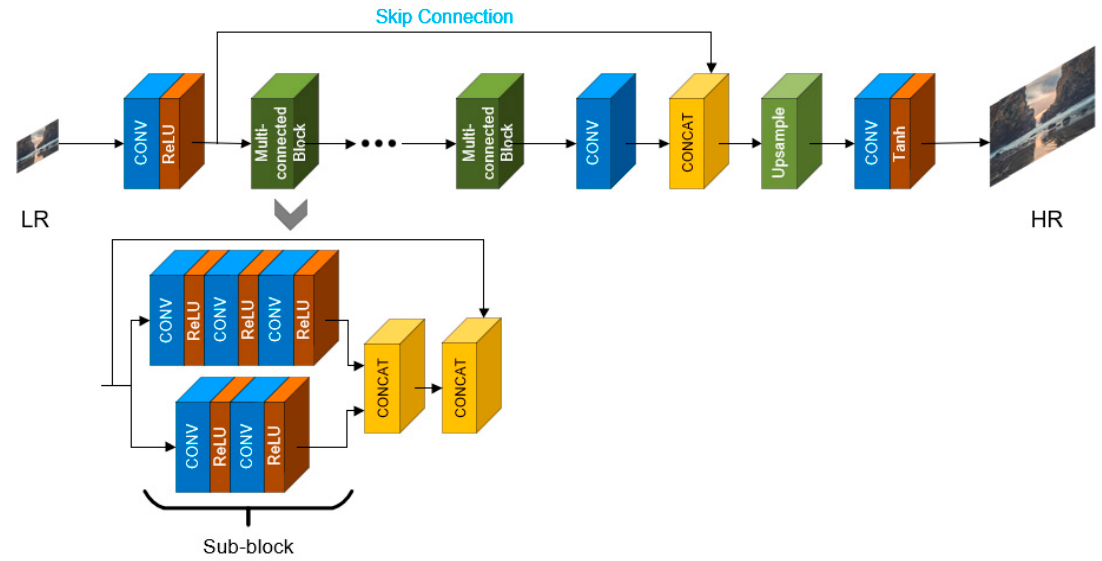
Figure 7. MCSR network structure.